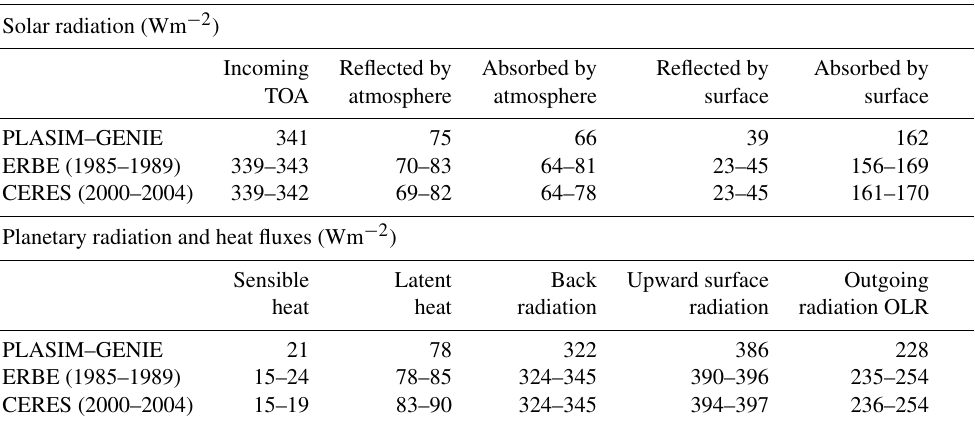
Table 2. The global energy balance of subjectively tuned PLASIM–GENIE in the preindustrial state compared against estimates derived from the Earth Radiation Budget Experiment (ERBE; 1985–1989), when the Earth’s radiation balance was in approximate equilibrium, and the Clouds and Earth’s Radiant Energy System (CERES) data (2000–2004). The observational uncertainties reflect a range of analyses summarised in Trenberth et al.